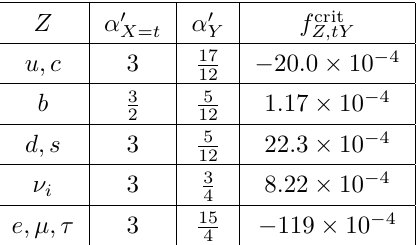
Table 1. The values of α 0